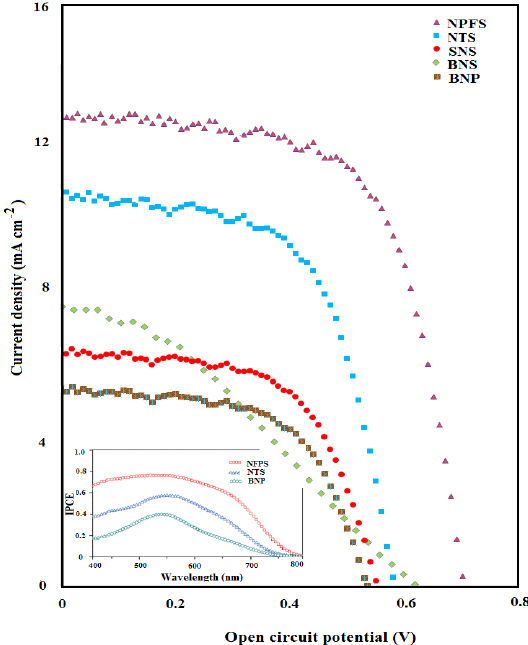
nanofibers 2 Fig. 5. J-V curves of different photoanode electrodes. The inset is IPCE spectra of DSSC constructed with BNP, TNS and NFPS Fig.5